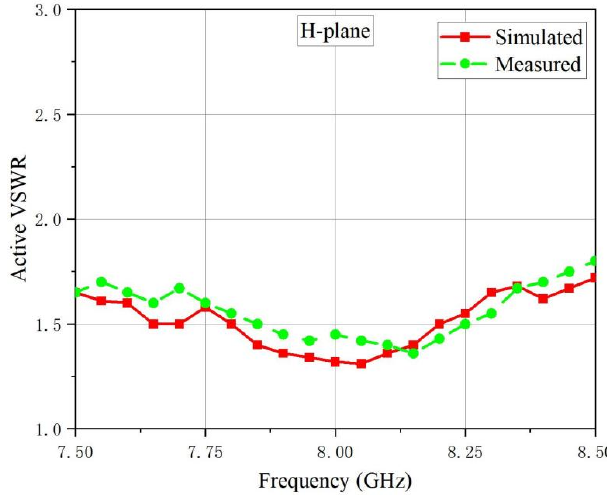
Figure 17. The active VSWR of the H ‐ plane.